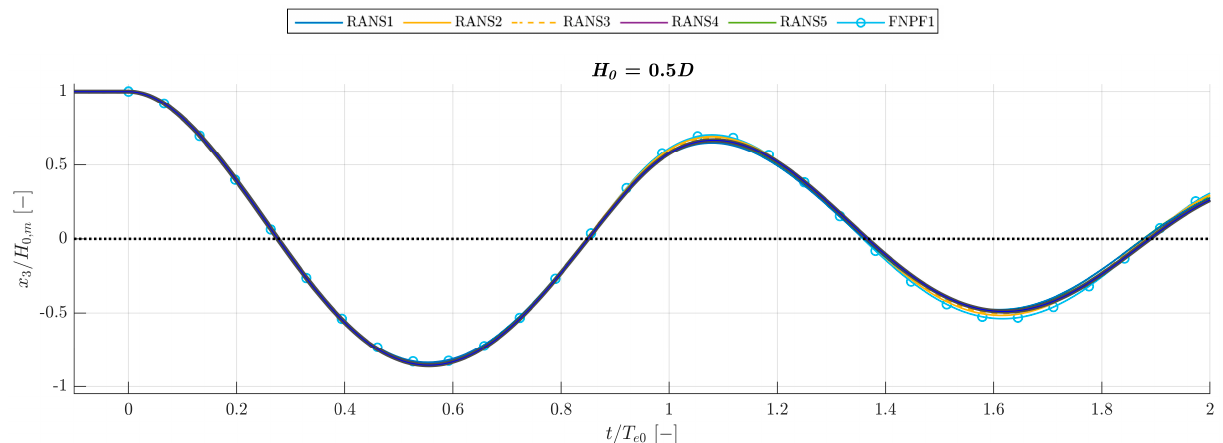
Figure 25. Comparison of physical and high-fidelity numerical test results with a zoom of 0 < 𝑡/𝑇 (cid:3032)(cid:2868) < 2 .